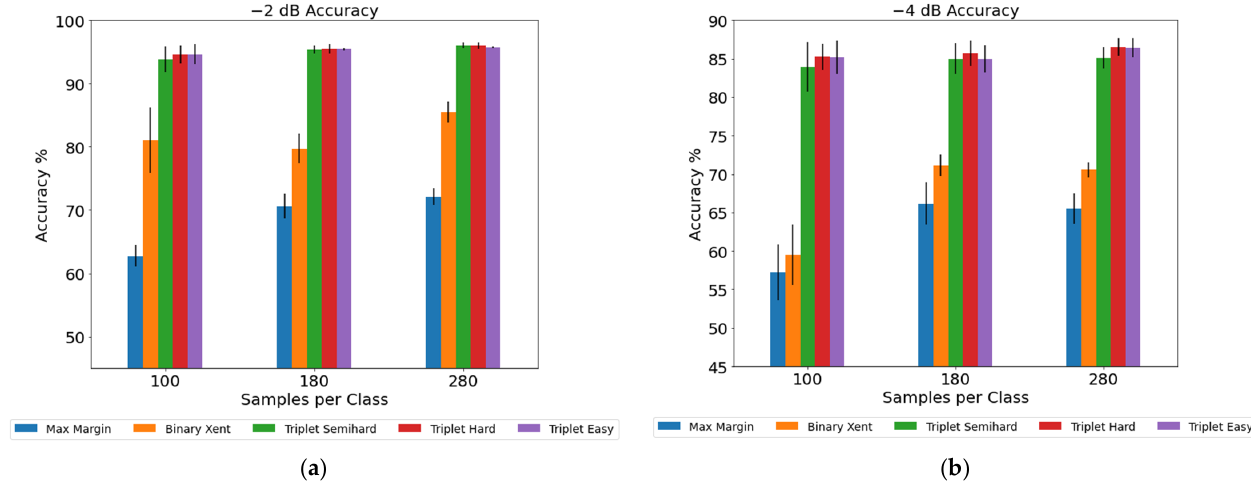
Figure 13. Accuracy of the max-margin, binary cross-entropy, and triplet semihard, hard, and hard-soft-margins when tested with the − 2 dB ( a ); and − 4 dB ( b ) signal-to-noise ratio noise test sets.